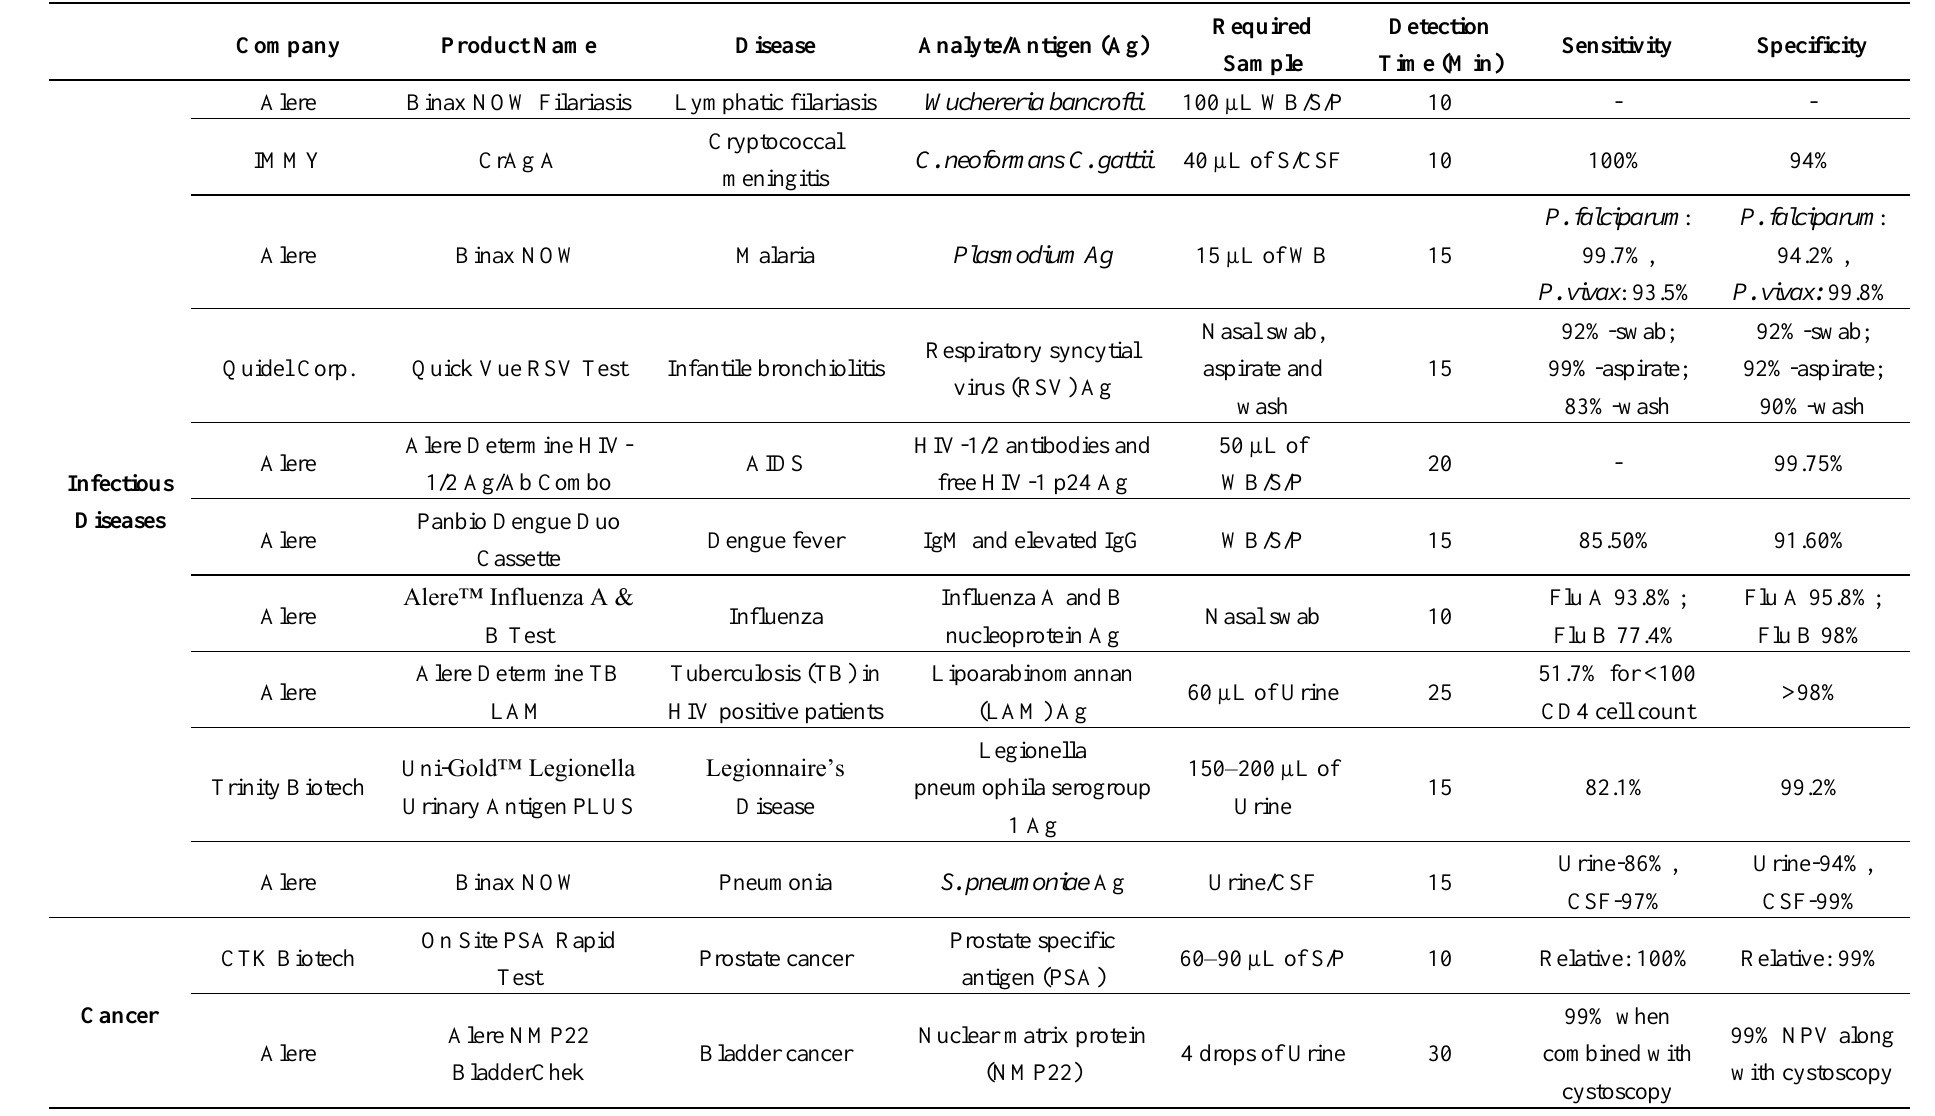
Table 1. Overview of commercially available lateral flow test strips: For detection of infectious diseases, cancer, and cardiac